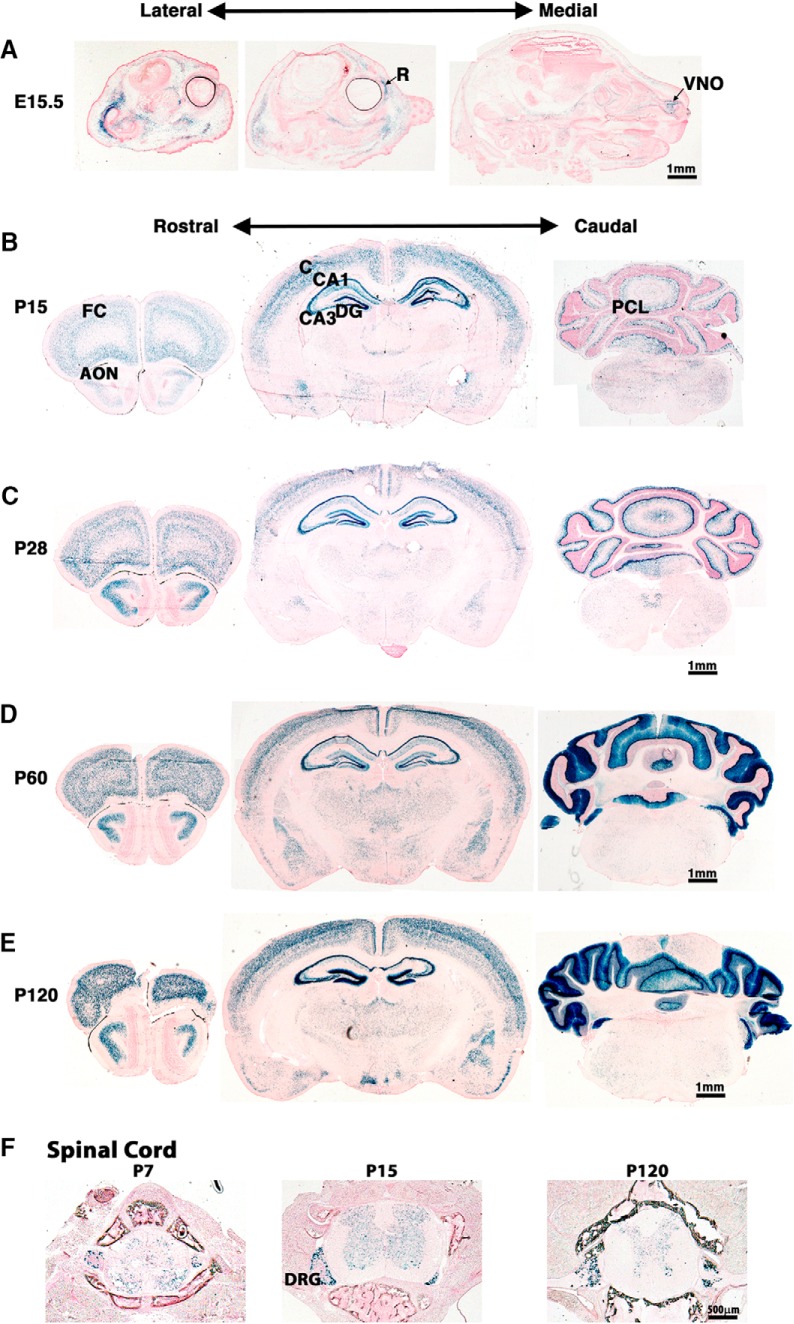
Expression profile of SynDIG1 reporter in the developing mouse brain. A, Sagittal sections from the entire head of E15.5 SynDIG1
β-gal homozygous mutant mouse show β-gal reporter activity (blue) within the retina (R) and vomeronasal organ (VNO), but little β-gal activity in the brain. B–E, Coronal sections of P15 (B), P28 (C), P60 (D), and P120 (E) mutant mouse brains show β-gal expression in the CA1, CA3, and DG in the hippocampus; in the PCL of the cerebellum; in the frontal cortex (FC); in the AON; and in the cortex (C). Scale bars, 1 mm. F, Cross sections of P7, P15, and P120 vertebrae show β-gal expression in the dorsal root ganglia (DRG) and within the spinal cord. Scale bar, 500 nm. All sections are counterstained with nuclear fast red.